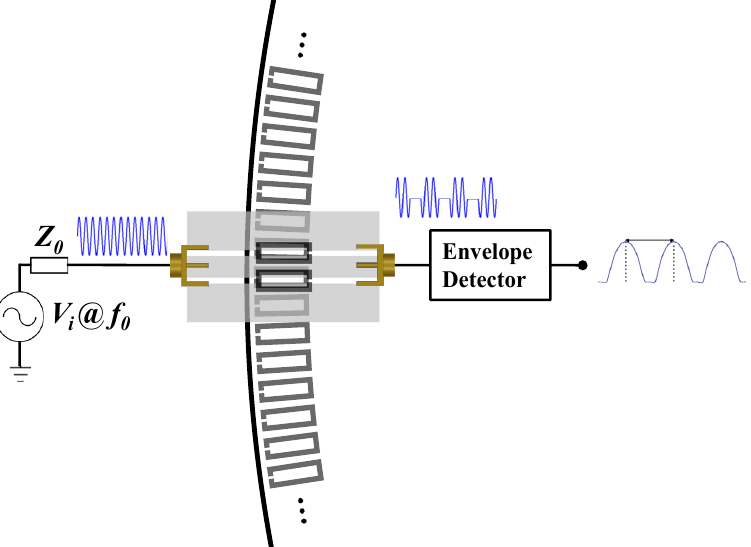
Figure 1. Sketch showing the working principle of an electromagnetic rotary encoder system based on a rotor with a circular chain of split-ring resonators (SRRs).